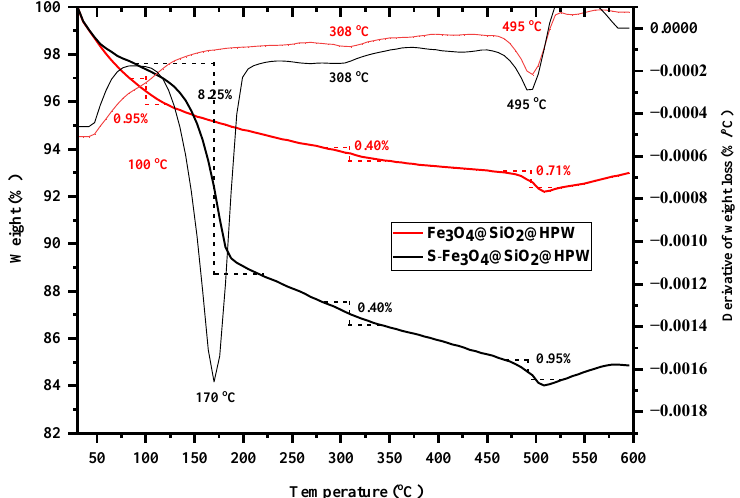
Figure 10. Thermogravimetric analysis (TGA) and derivative thermogravimetry (DTG) analysis of